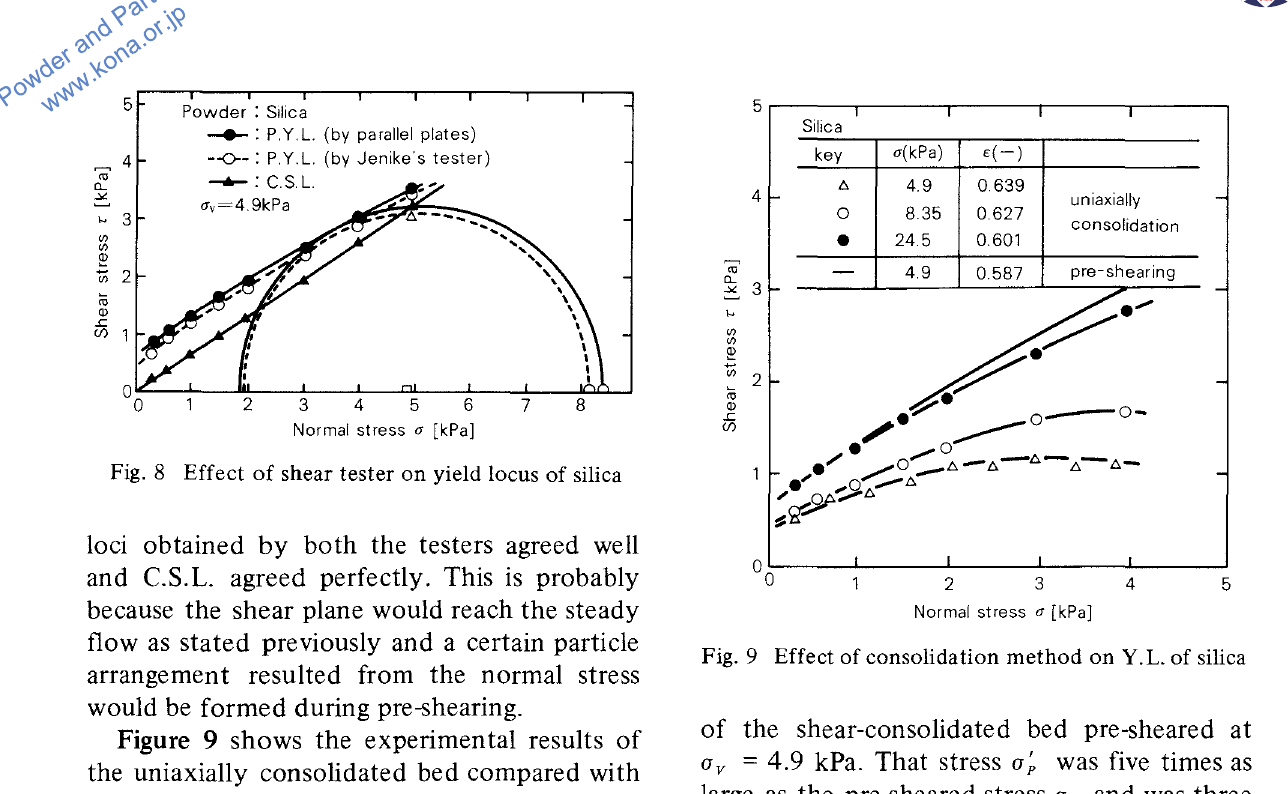
Fig. 8 Effect of shear tester on yield locus of silica